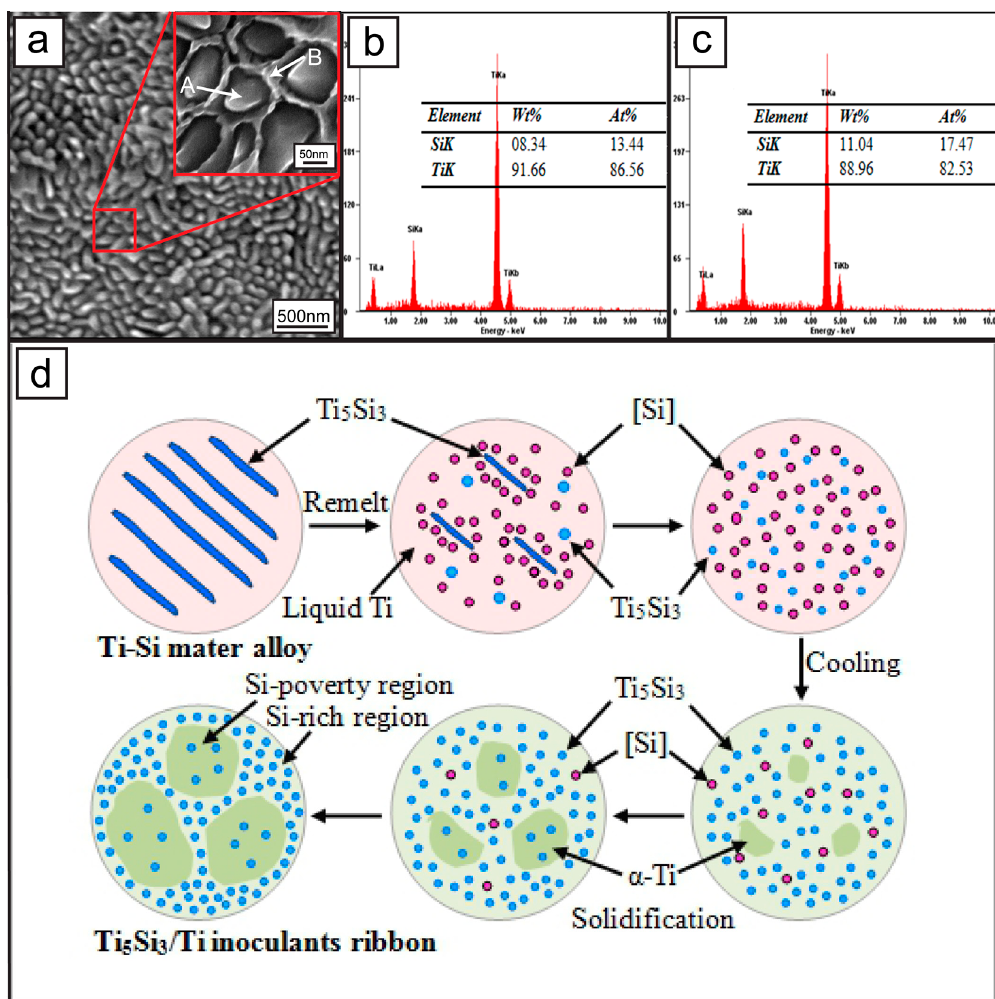
Figure 4. Microstructures of the in situ Ti 5 Si 3 /Ti composite inoculants and the schematic diagram of its formation process: ( a ) microstructures; ( b ) energy-dispersive spectrometry (EDS) result of point A; ( c ) EDS result of point B; ( d ) the schematic diagram of the cellular formation.